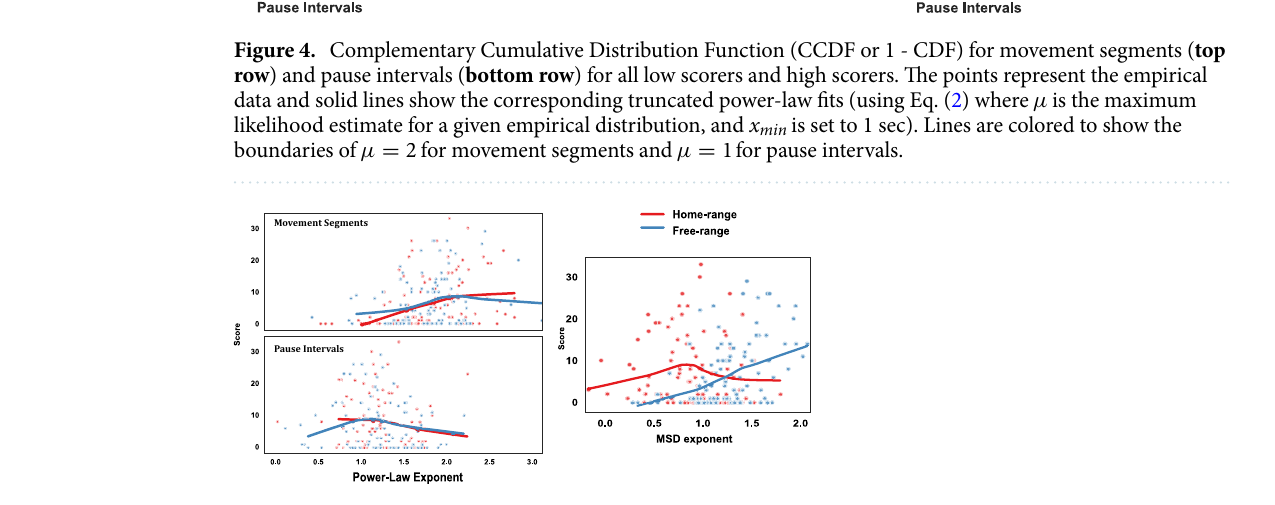
Figure 5. Individual scores as a function of truncated power-law exponents (left) for movement segments and pause intervals, and diffusion exponents (right) for home-range versus free-range foragers. The solid lines show the respective moving